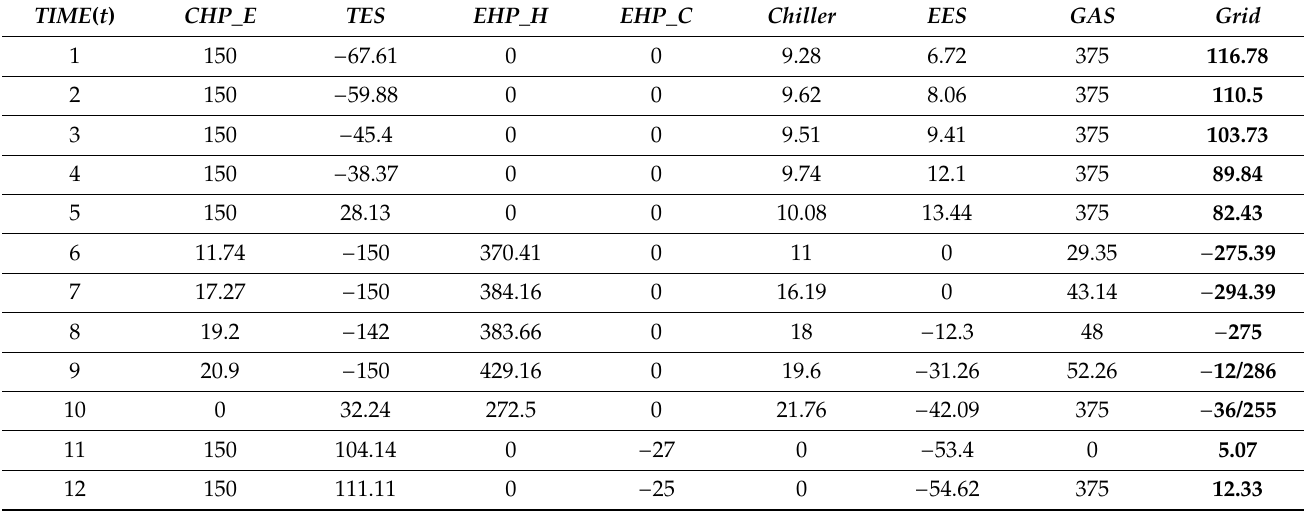
Table 8. Operation energy hub for deterministic